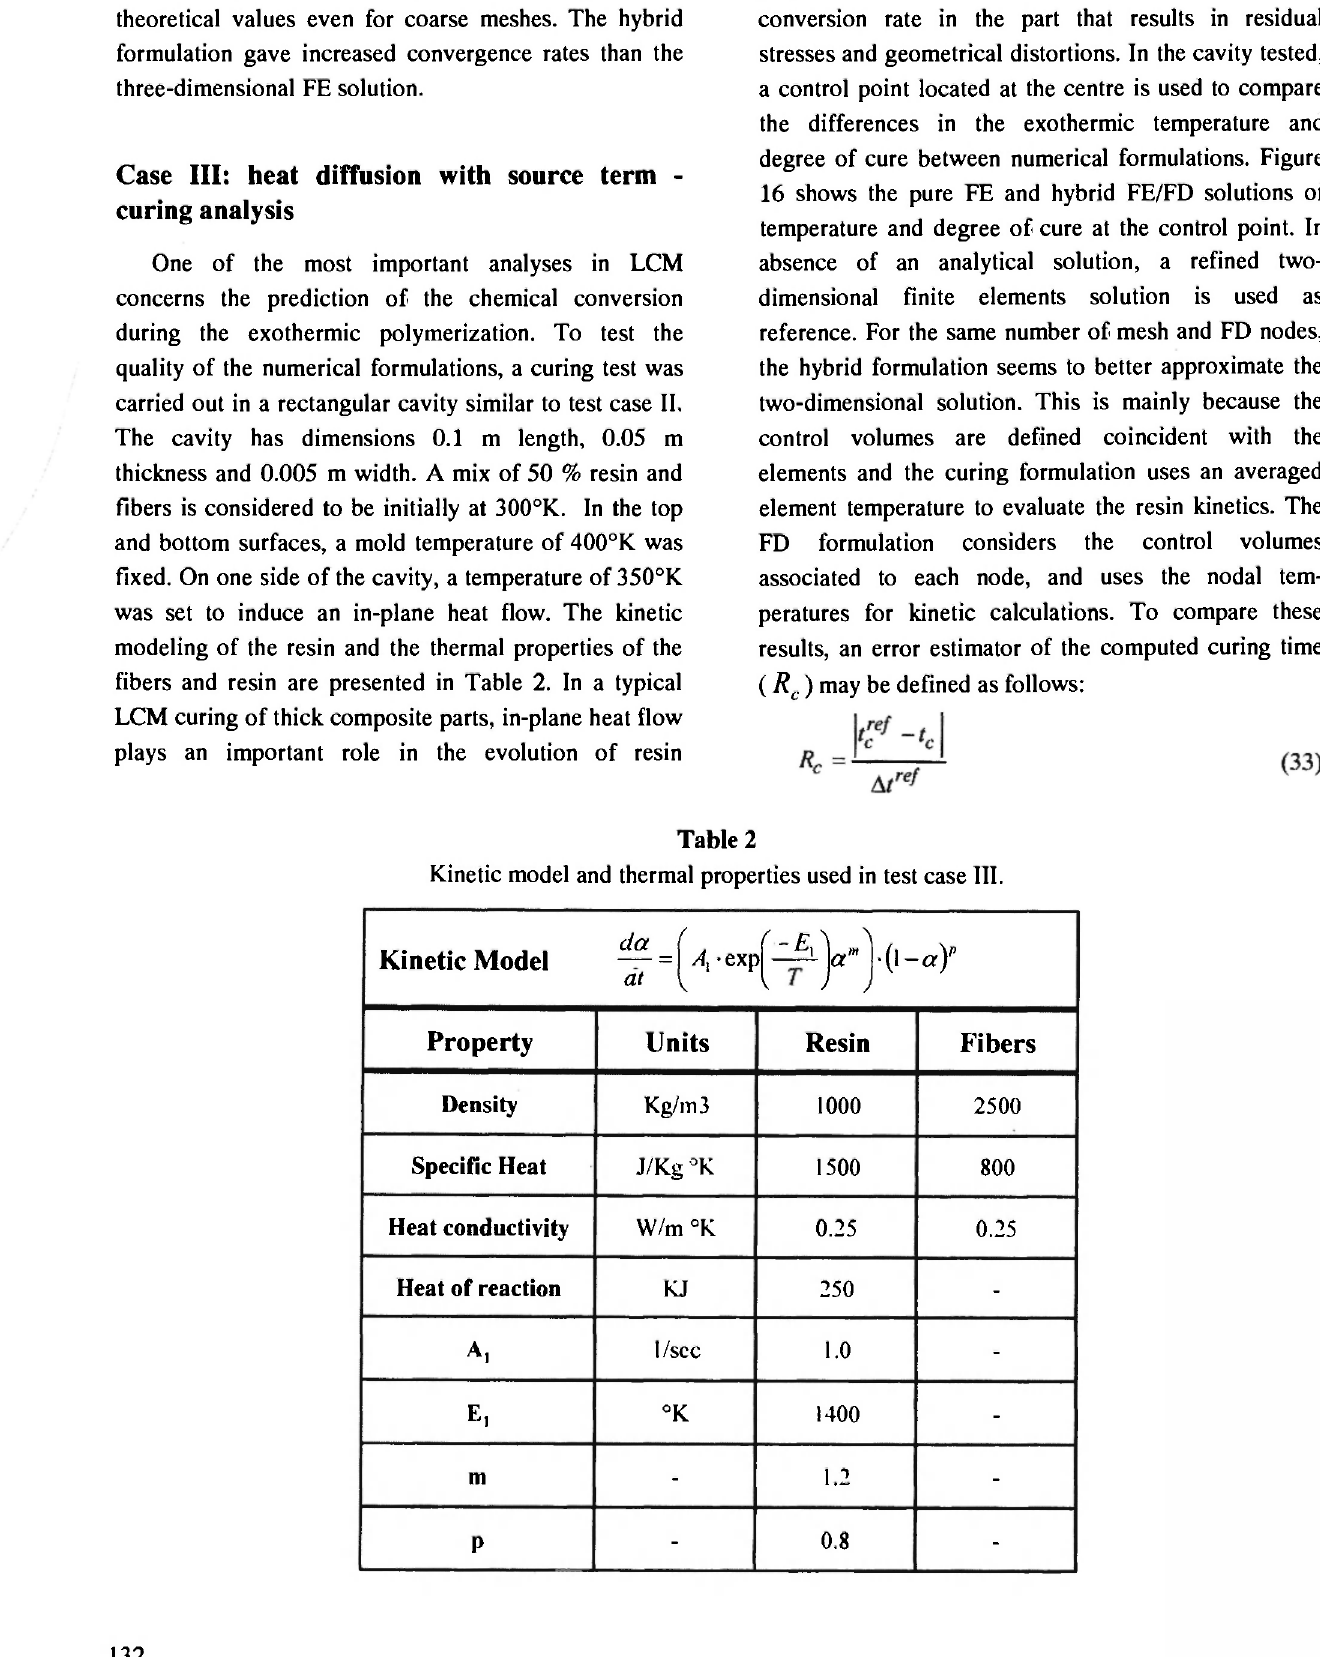
Kinetic model and thermal properties used in test case